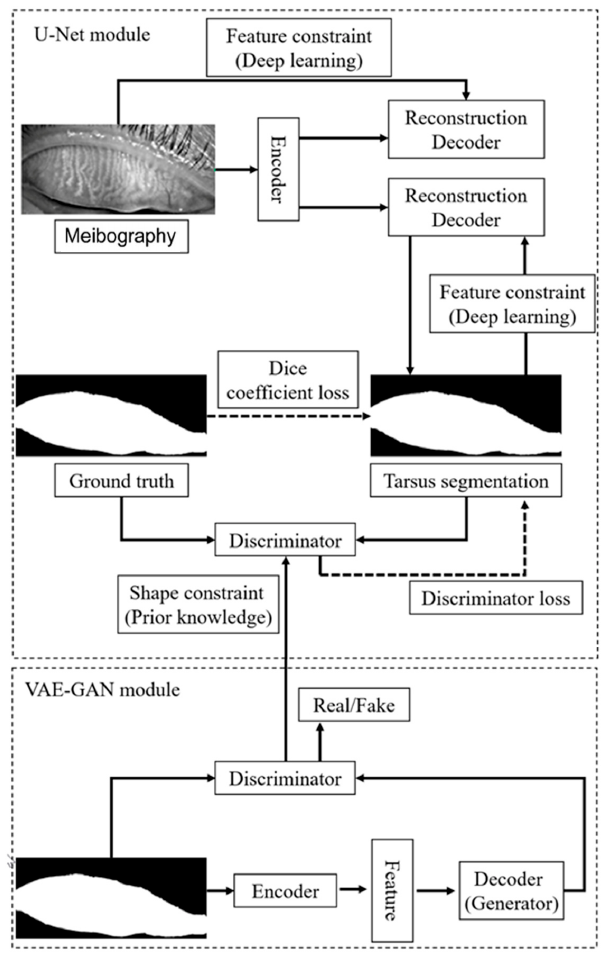
Figure 3. The framework of VAE-GAN and U-Net.